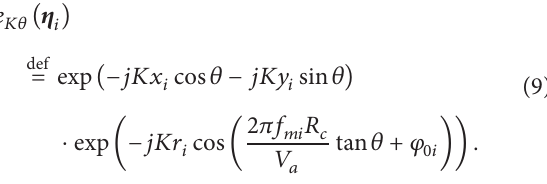
Substituting (6) into (5), discretizing the result, and adding noise